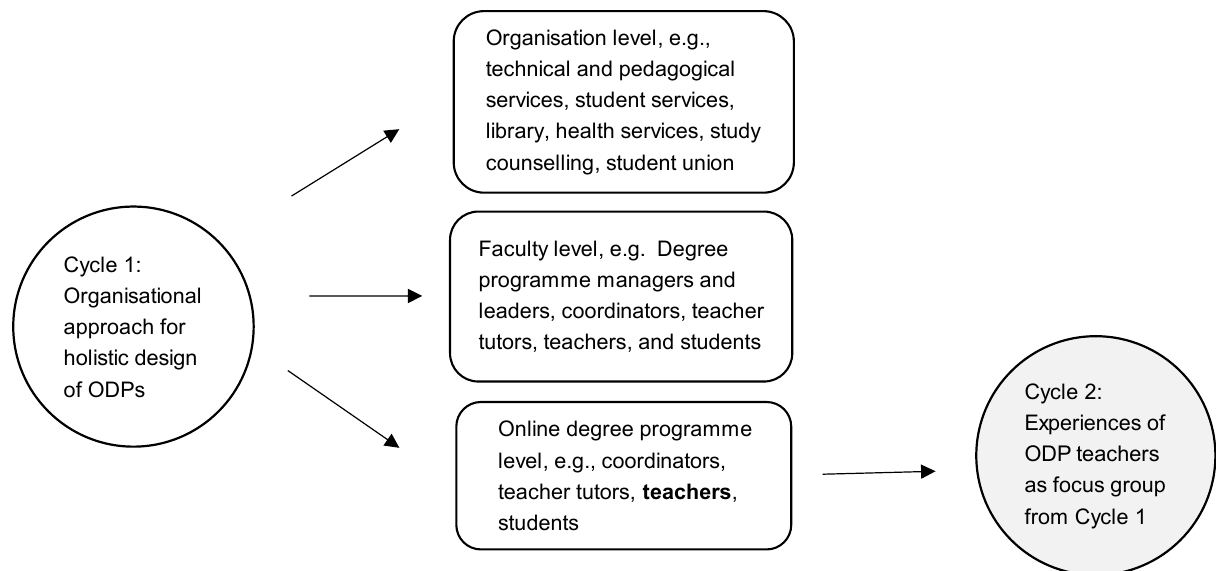
Stakeholders in Cycles 1 and 2 of the DBR